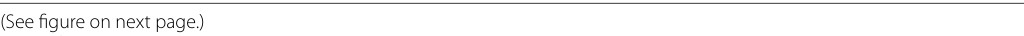
3 magnification of those areas. All ×